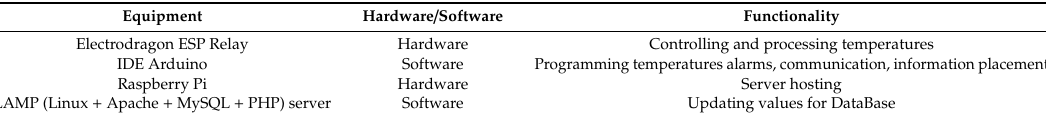
Table 4. Open-source equipment for the proposed Table 4. Open ‐ source equipment for the proposed solution.